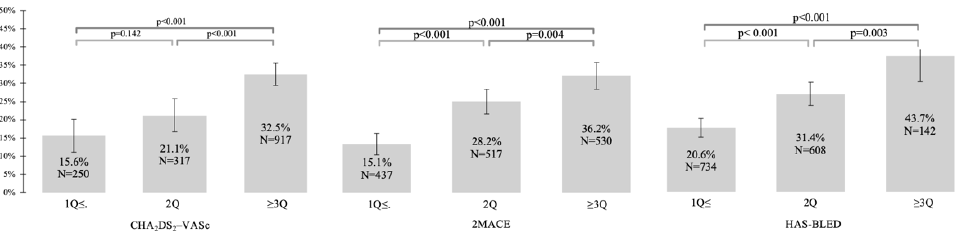
Figure 2. Relationship between all-cause mortality and CHA 2 DS 2 -VASc, 2MACE, and HAS–BLED scores in the group of patients with atrial fibrillation. Abbreviations: Q, quartile.